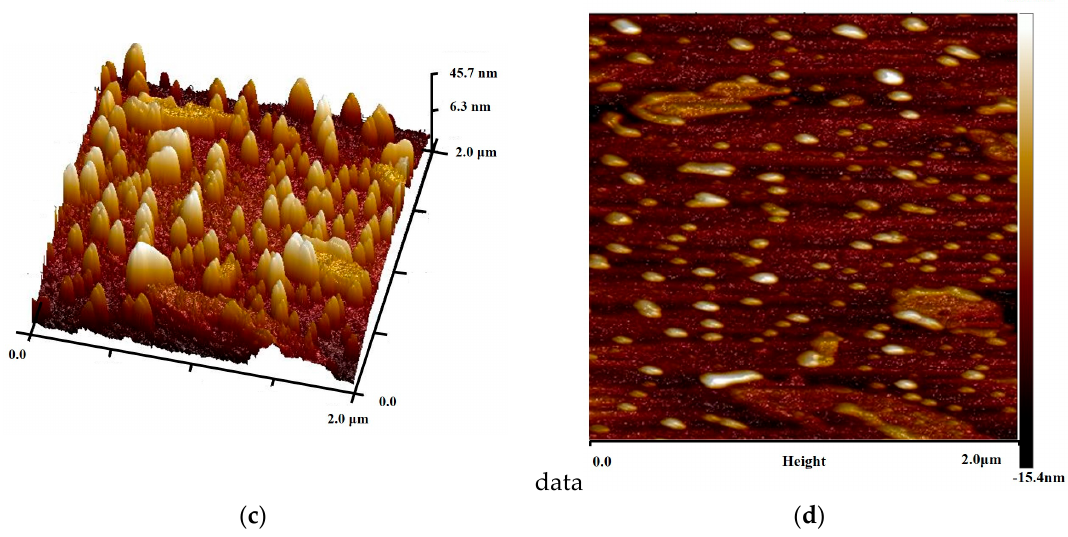
Figure 2. AFM ( a ) 3D and ( b ) 2D images of pyrite, AFM ( c ) 3D and ( d ) 2D images of pyrite with humic-acid.